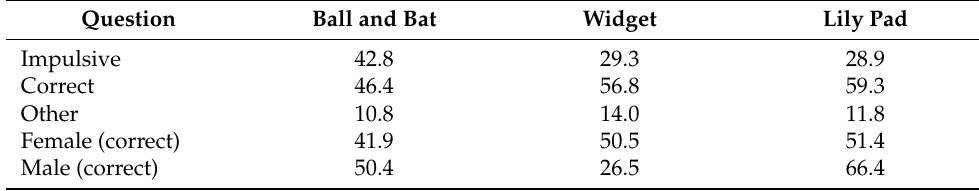
Table A7. CRT score per